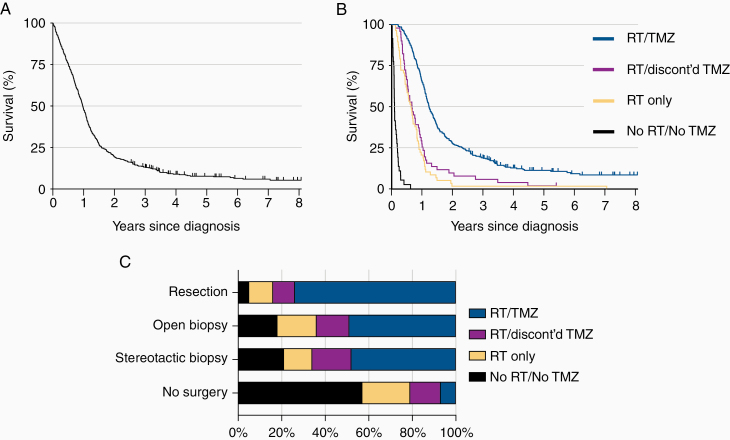
Patterns of care and survival in a GBM population. (A) Overall survival in the whole population. Vertical line represents censored events. (B) Overall survival of pathologically confirmed GBM stratified according to postoperative oncological treatment. (C) Receipt of RT and TMZ among the patients by type of surgery. GBM, glioblastoma; RT, radiotherapy; TMZ, temozolomide.